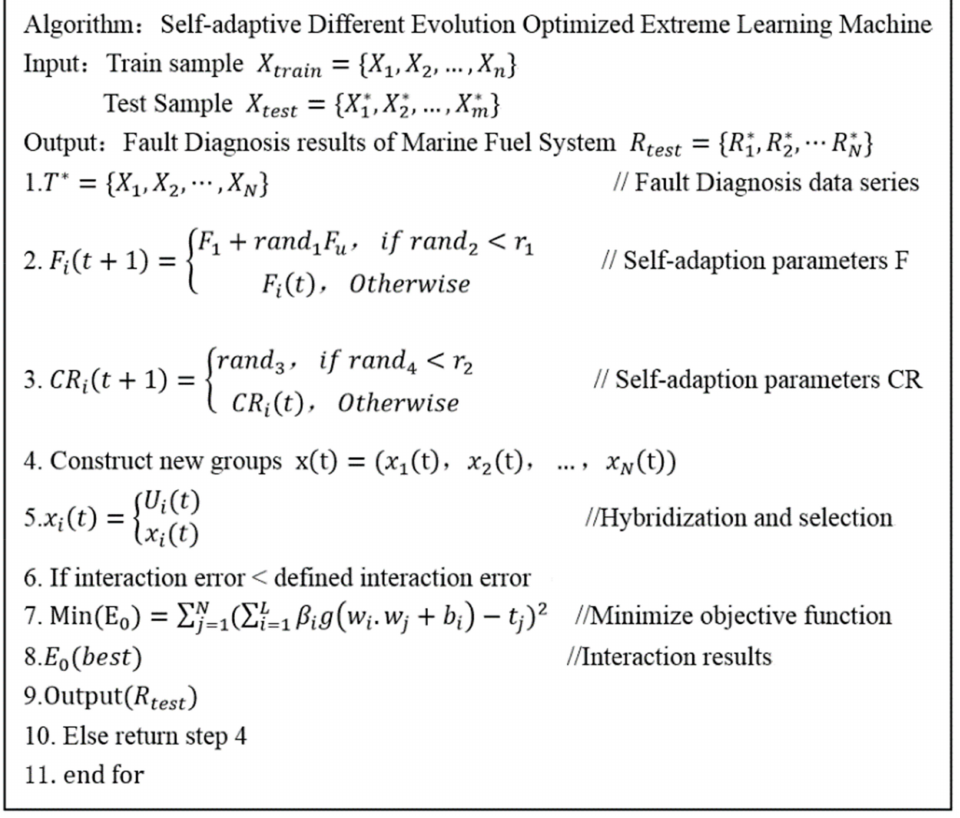
Figure 5. Pseudocode of the proposed SaDE-ELM